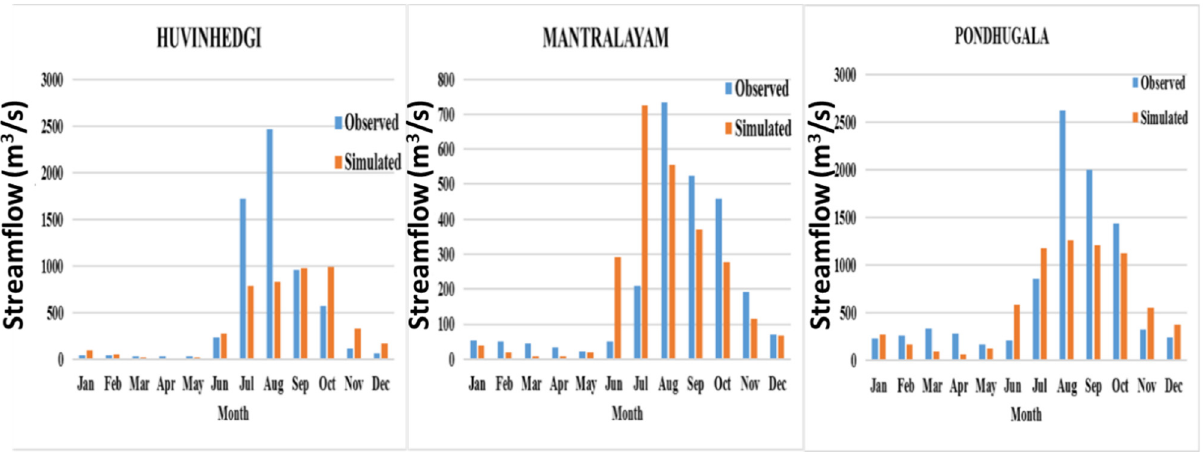
Figure 7. Observed and SWAT-simulated streamflow at three gauge stations for the Historic period (1975–2005).